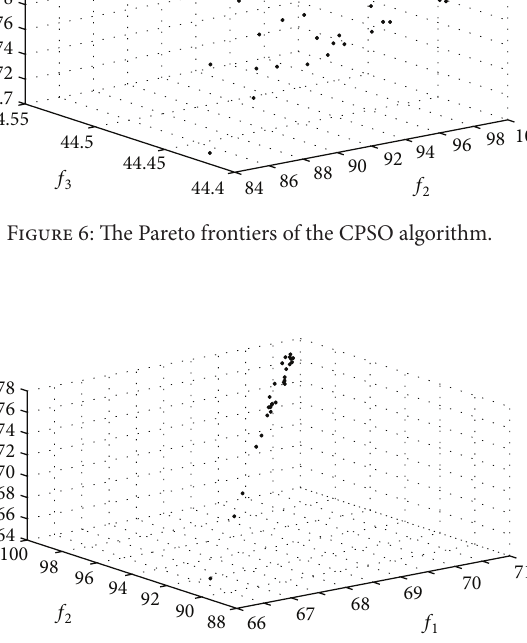
Figure 7: The Pareto frontiers of the CDE